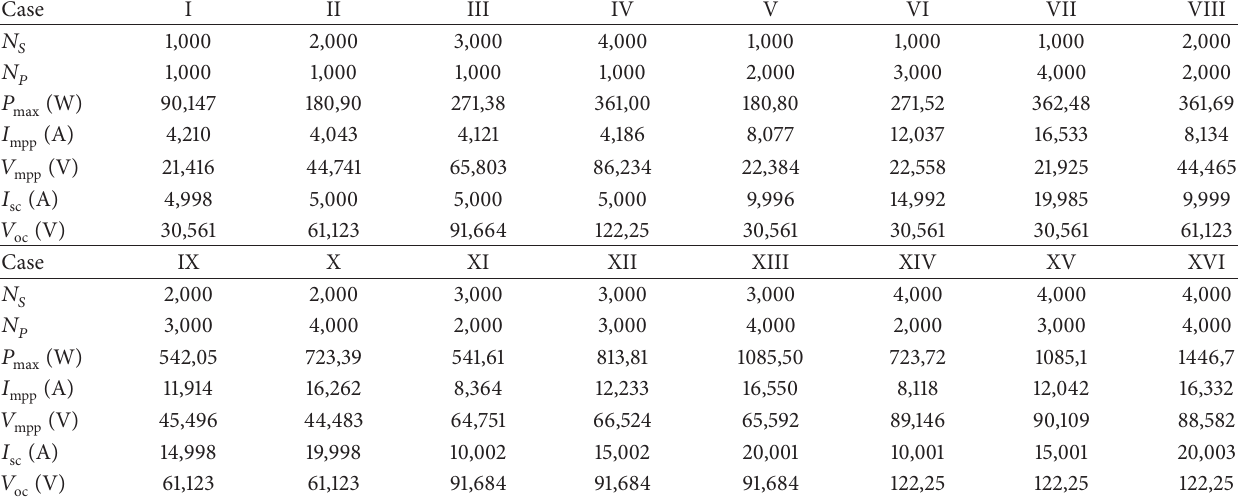
Table 1: The PV array characteristics experiment parameters and outputs.